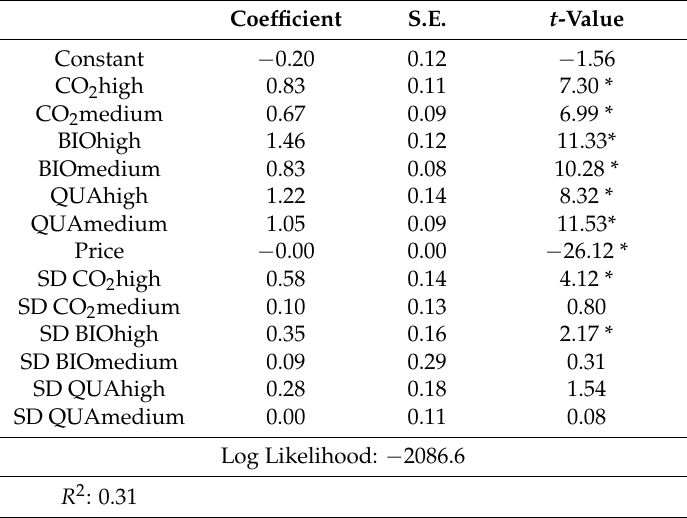
Table 4. Estimation results of random parameter logit model.